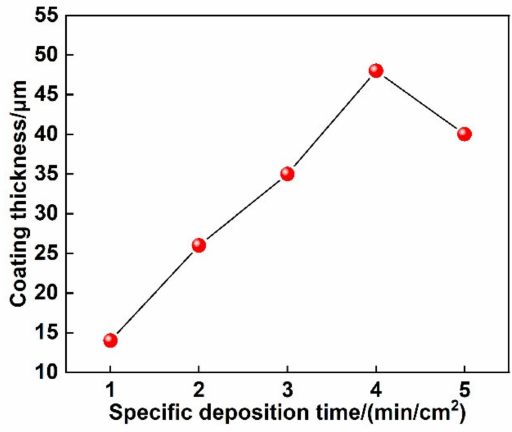
Figure 10. Effect of specific deposition time on the thickness of